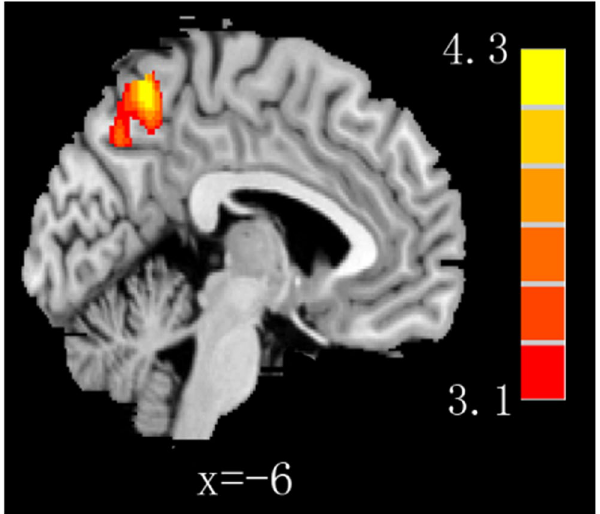
Figure 1. An interaction effect between cognitive empathy group and SEHS found in regions of the bilateral PCU. SEHS, self-enhancing humor style; PCU, precuneus.